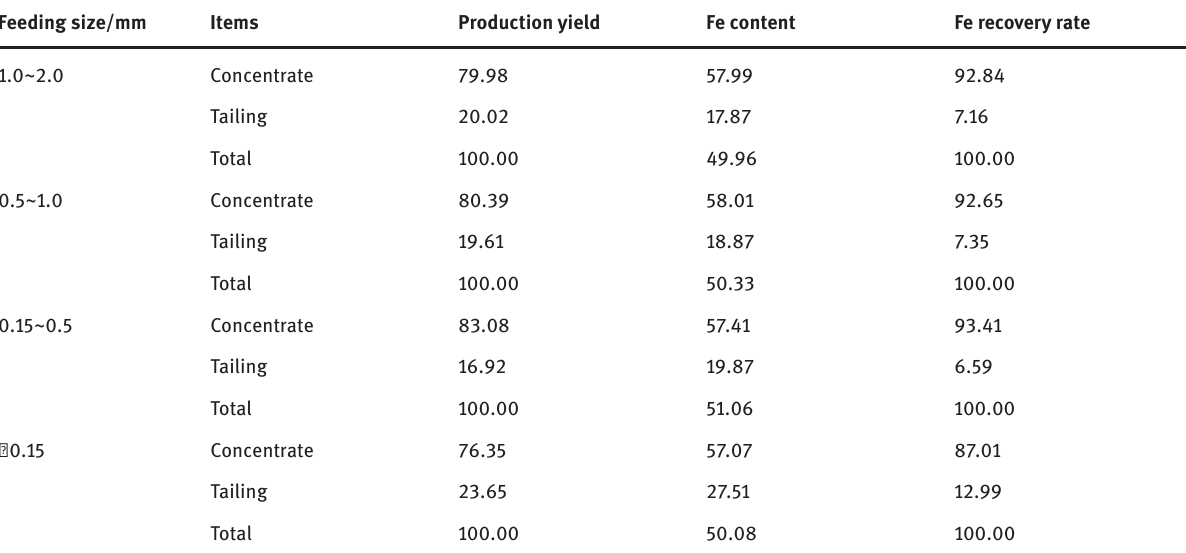
Table 7: Particle size for roasting and its corresponding result (mass, %) of Magnetic Tube separation.